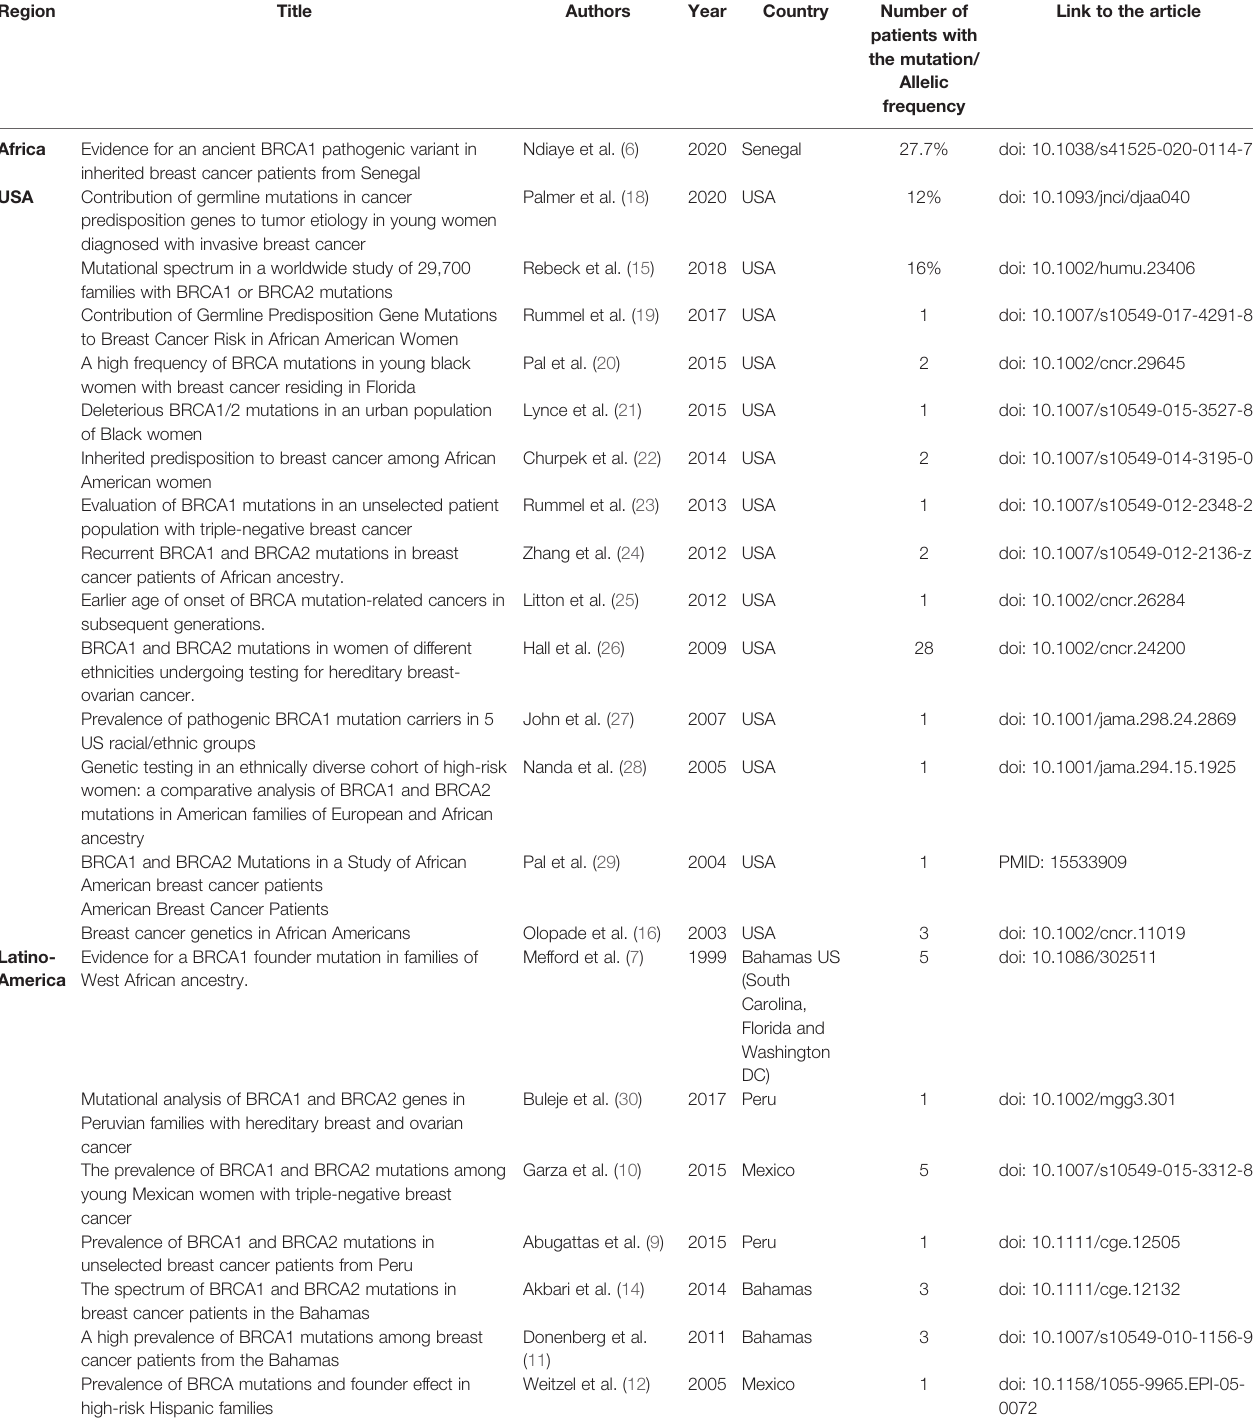
TABLE 1 | Studies reporting the c.815_824dup pathogenic variant throughout the world.